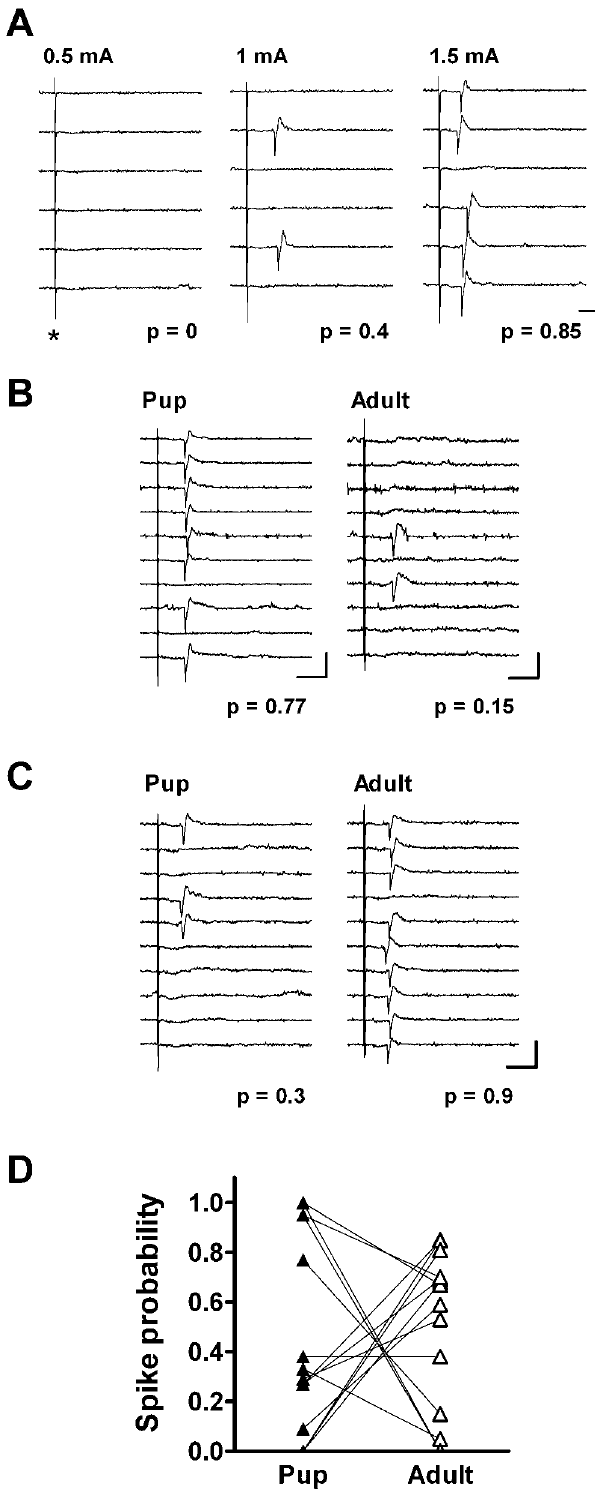
Figure 8. Firing Behavior Elicited by Excitatory Inputs (A) Action currents in cell-attached configuration recorded from an adult- born DGC in response to MPP stimulation at increasing stimulus strengths (0.5–1.5 mA, 50 l s). Six representative epochs are shown. Spiking probability (p) is shown below the traces. The asterisk (*) marks the stimulation artifact. Scale indicates 10 ms, 50 pA. (B) Sample experiment of simultaneous cell-attached recordings of DGCs born in pup and adult brain in response to MPP stimulation (0.4 mA,